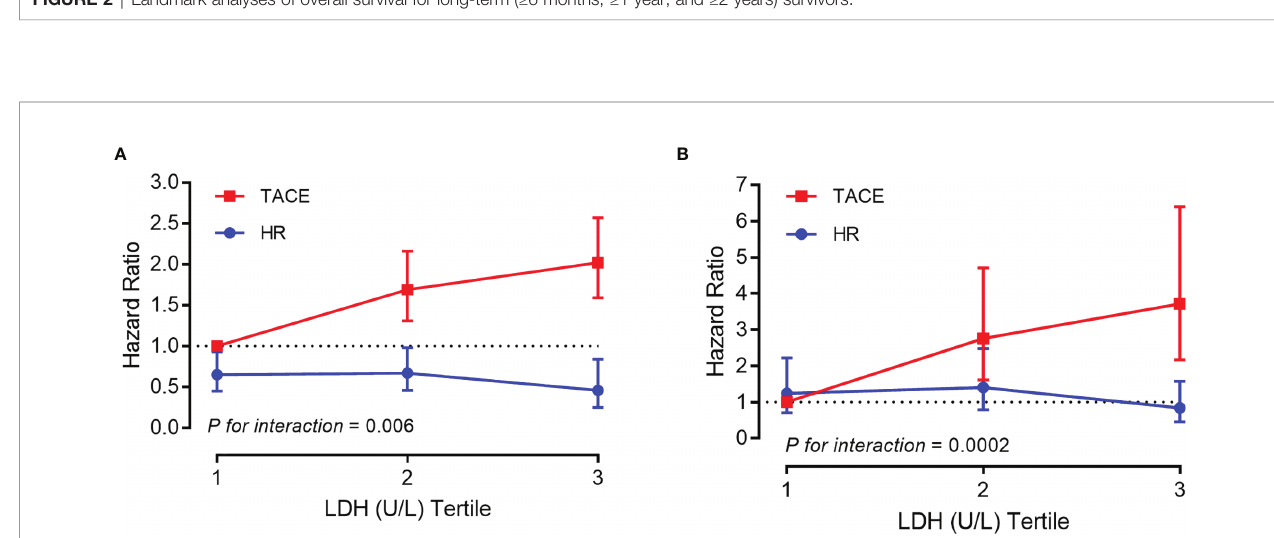
FIGURE 3 | Association between overall survival and platelet count/lactic dehydrogenase strati fi ed by tertile before (A) and after (B) propensity score (PS) matching [ vs. transarterial chemoembolization (TACE) in the bottom tertile].